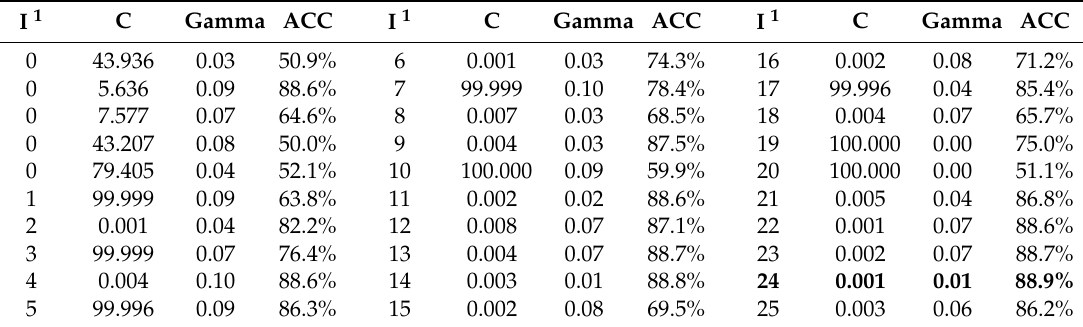
Table 8. The Confusion Matrix of the SVM Classifier.